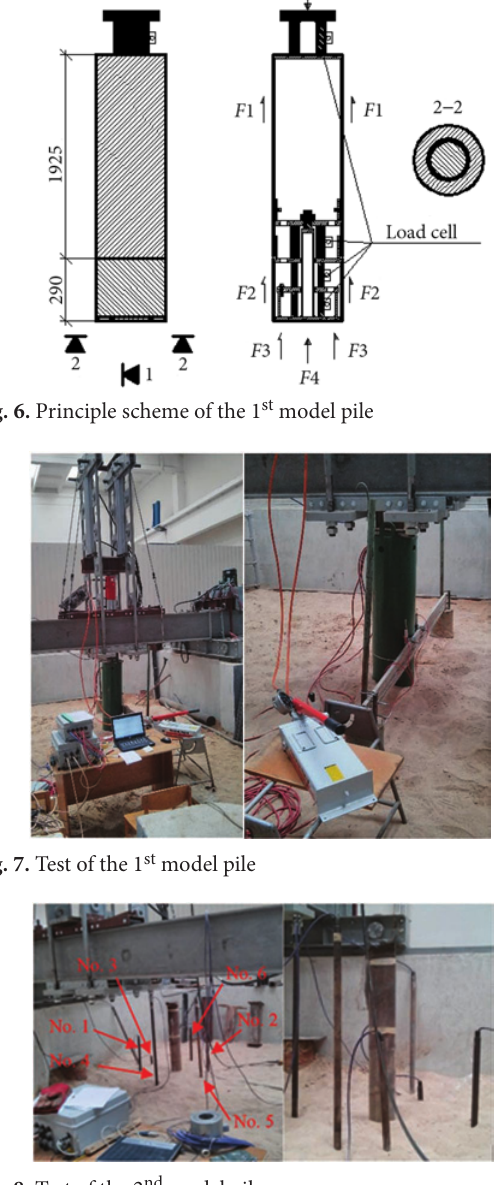
fig. 8. Test of the 2 nd model